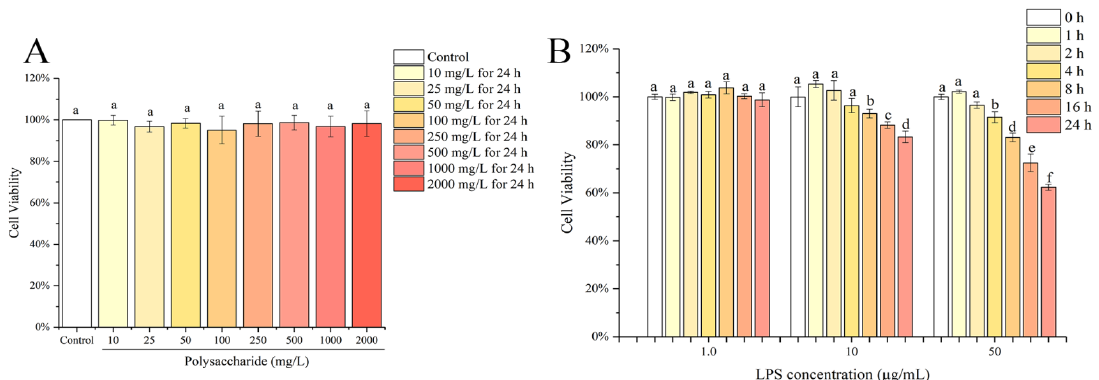
Figure 1. ( A ) Effects of HSP-W on Caco-2 cell viability, ( B ) effects of LPS on Caco-2 cell viability [28]. Different letters represent the significant difference at p < 0.05.